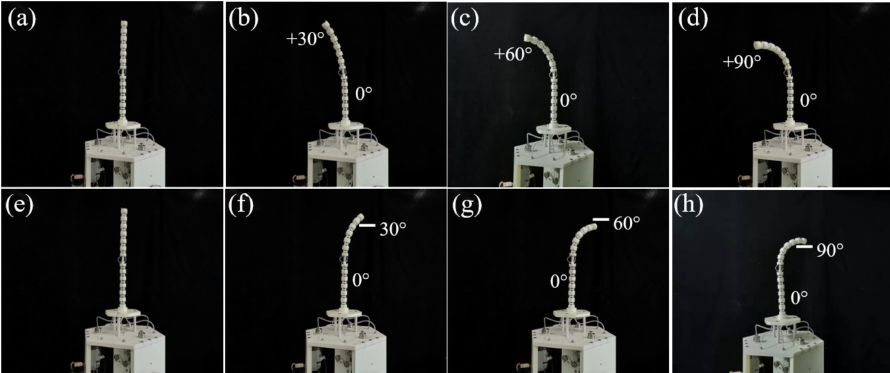
Figure 21. Bending configurations of the distal segment. ( a ) The initial configuration. ( b ) The configuration with the bending angle of +30 ◦ . ( c ) The configuration with the bending angle of +60 ◦ . ( d ) The configuration with the bending angle of +90 ◦ . ( e )The initial configuration. ( f ) The configuration with the bending angle of − 30 ◦ . ( g ) The configuration with the bending angle of − 60 ◦ . ( h ) The configuration with the bending angle of − 90 ◦